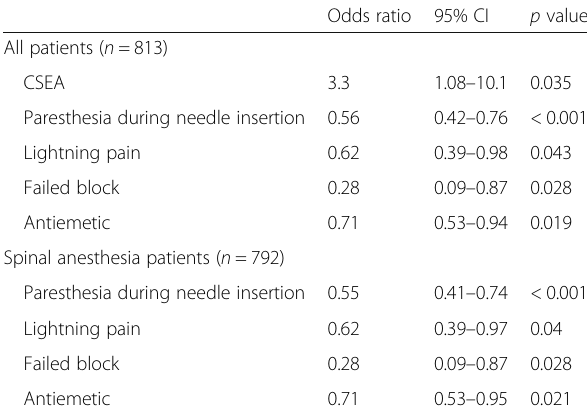
Table 2 Multivariate logistic regression model for the satisfied